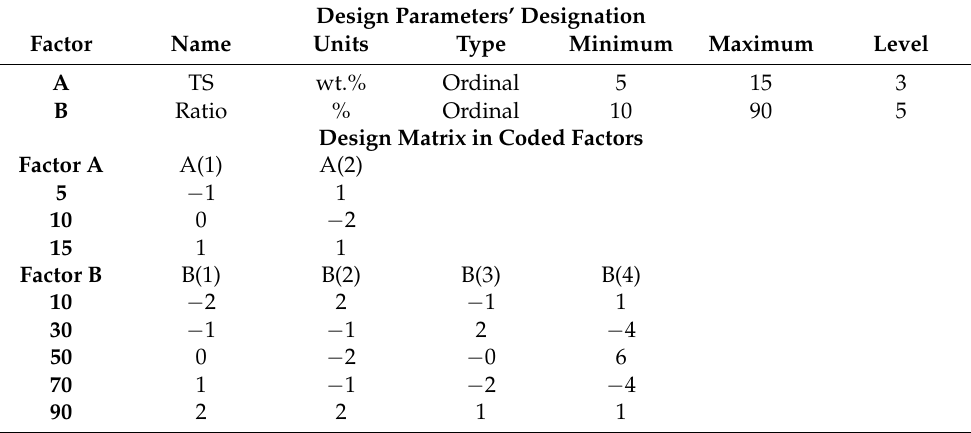
Table 3. DOE design parameters and design matrix with factors’